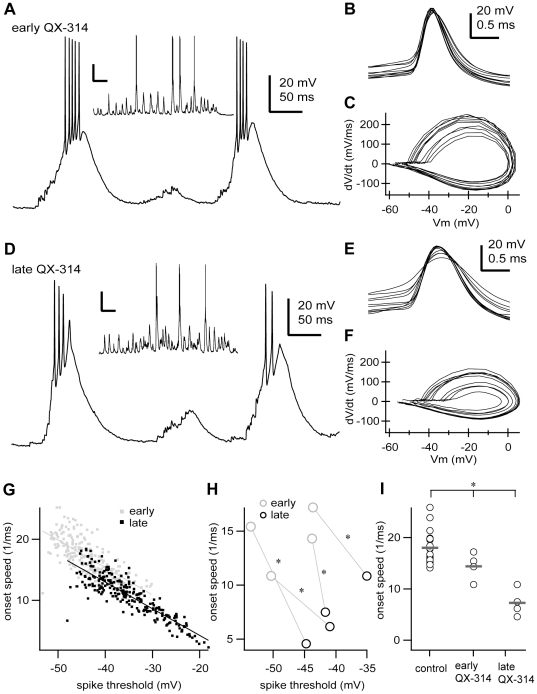
The onset speed of action potentials depends on the effective density of available sodium channels.
A, In vivo intracellular low-threshold burst discharges of a TRN neuron recorded during the first 10 minutes after impalement with a recording pipette loaded with QX-314 (0.5 M). Inset, typical episode of spindle oscillations from the same cell (pentobarbital anaesthesia). B, Sample of consecutive action potentials (n = 10) from the cell shown in A. C, Phase plane representation of the action potentials shown in B. D, Same cell as in A, recorded 25 minutes after impalement. Inset, example episode of spindle oscillations. E, Sample of consecutive action potentials (n = 10) recorded 25 minutes after impalement. F, Phase plane representation of the action potentials shown in E. G, Plot of the onset speed of action potentials versus the voltage threshold for the cell shown in A–F during the first 10 minutes of recording (early QX-314, n = 212 spikes) and after 25 minutes of recording (late QX-314, n = 254 spikes). H, Plot of the mean onset speed of action potentials versus the mean voltage threshold for each of the cells recorded with QX-314. Changes were statistically significant in all cells (p<0.05, two-tailed paired two-tailed t test). I, Onset speed of action potentials for all cells recorded in this study. Circles and grey bars show individual values and means, respectively. Control, data from neurons recorded without QX-314; early QX-314, data from neurons during the first 10 minutes of recording with QX-314; late QX-314, data from neurons after 25–50 minutes of recording with QX-314. Control, n = 23 cells, 32576 spikes; early QX-314, n = 4 cells, 1728 spikes; late QX-314, n = 4 cells, 386 spikes. Mean values were significantly different (*, p = 0.0004, Kruskal-Wallis test). Scale bars: A,D, vertical 20 mV, 50 ms; inset, vertical 20 mV, 0.5 s; B, E, vertical 20 mV, 0.5 ms. Some portions of raw data (intracellular voltage recordings) from the cell in this figure have been used in previous publications (see Methods).